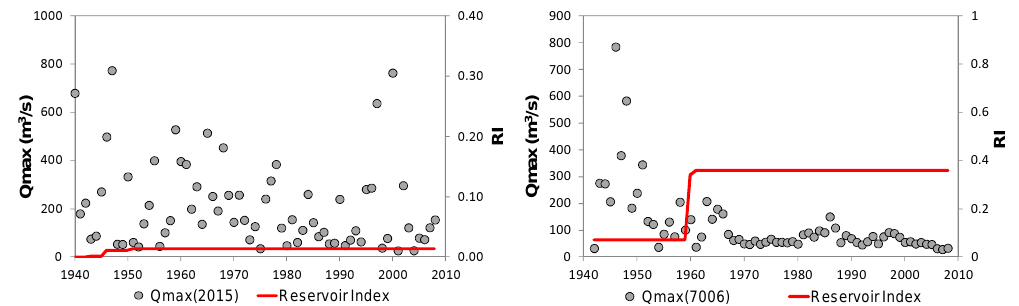
Figure 2. Temporal evolution of the reservoir index ( RI ) and annual maximum floods (Qmax), for the flow 714 Fig. 2. Temporal evolution of the reservoir index (RI) and annual maximum floods (Qmax), for the flow gauge stations 2015 (left, low altered gauge stations 2015 (left, low altered regime) and 7006 (right, high altered regime). 715 regime) and 7006 (right, high altered regime).